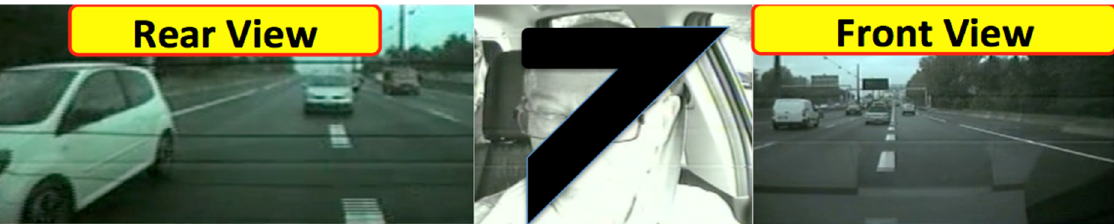
Figure 3. Typical example of driving error during a lane change (on the left ) on highway.